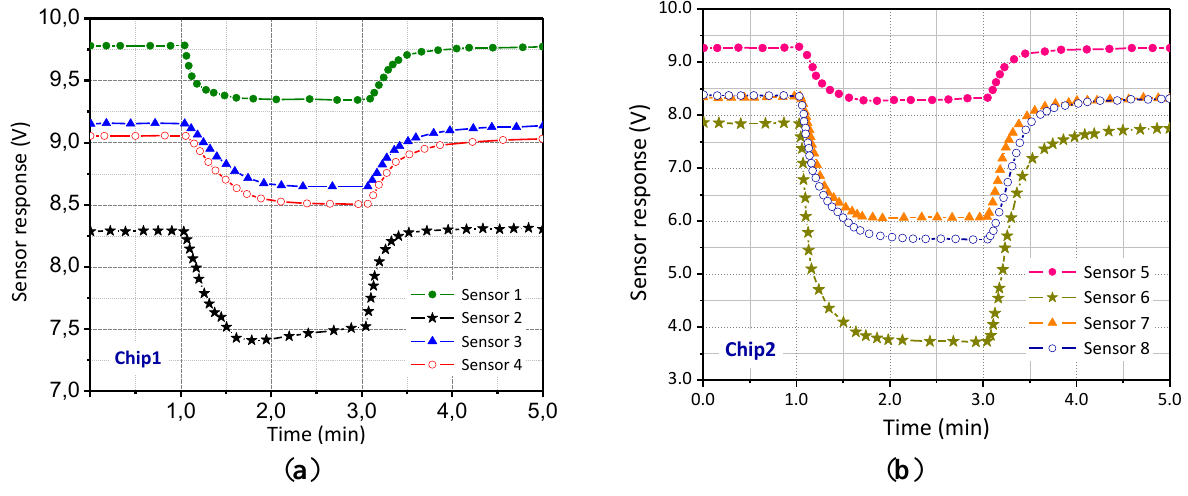
Figure 5. Typical response of the sensors array. The figure on the left shows the response of chip 1, whereas the figure on the right shows the response of chip 2. The voltage measurement of the sensor decrease when exposed to the analysed gases.